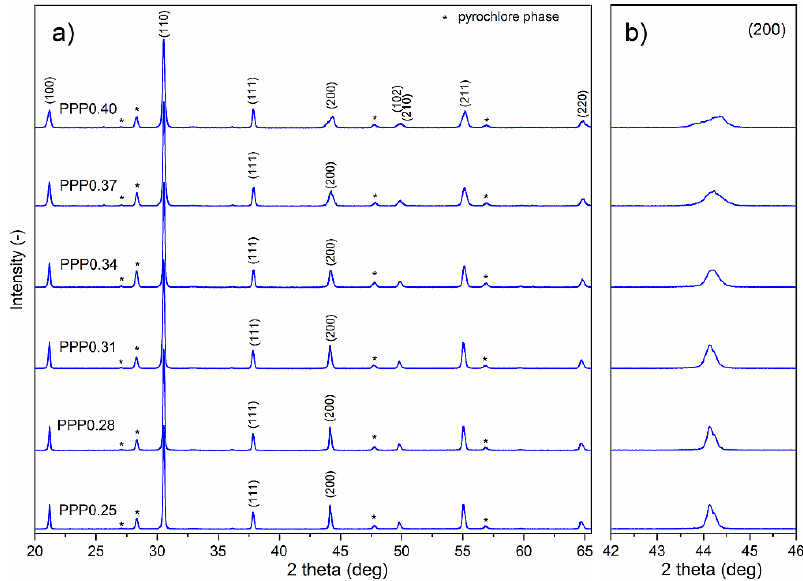
Figure 1. ( a ) XRD patterns for (1 − y ) ((1 − x )Pb(Mg 1/3 Nb 2/3 )O 3 – x PbTiO 3 )– y PbSnO 3 (PMN–PT–PS) solid solutions; ( b ) selected enlarged region; * pyrochlore phase.